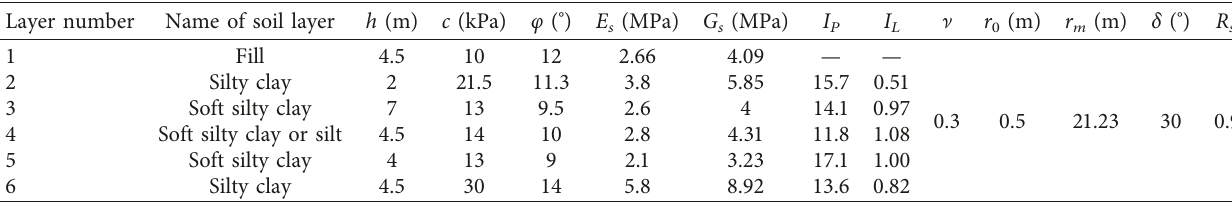
Figure 9: Plan of Fengqi Road metro station and measurement points in adjacent buildings. M6–M16 are the pile numbers. Table 2: Soil profiles and parameters of Fengqi Road excavation.